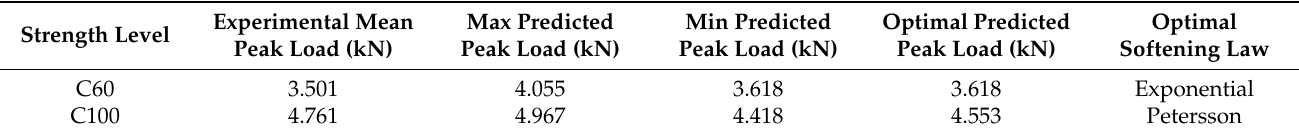
Table 2. Predicted peak loads using the PF-CZM with different softening laws.